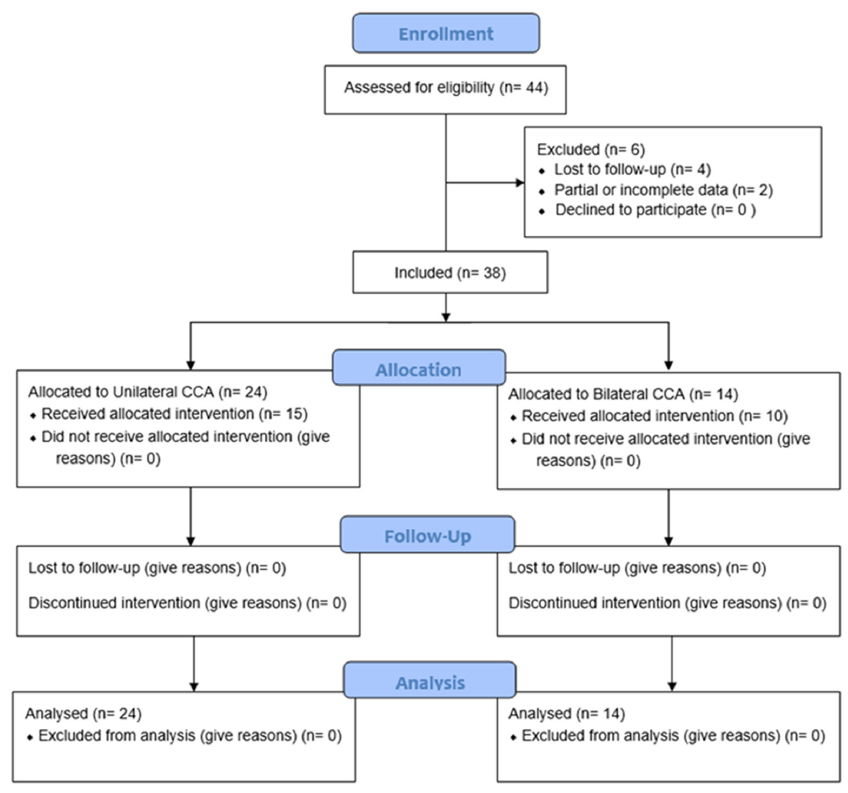
Figure 1. CONSORT 2010 Flow Diagram.